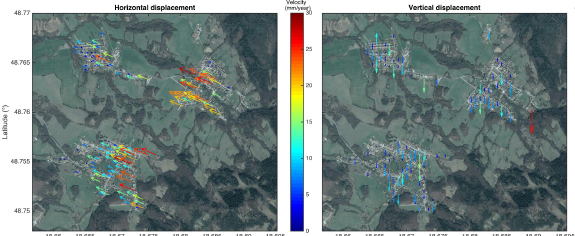
Figure 3. Horizontal (descending azimuth look direction) and vertical (up and down direction) displacement velocities in centres of the regular grid (50 x 50